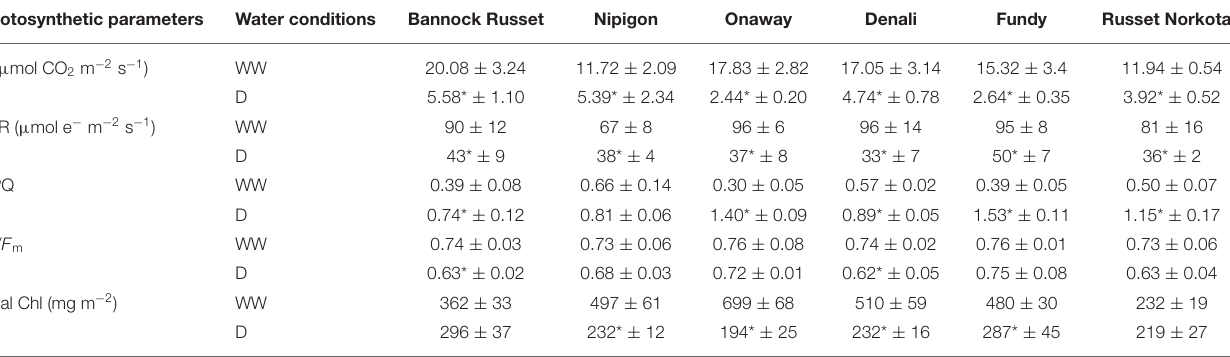
TABLE 2 | Effects of drought stress on photosynthetic and fluorescence characteristics of six potato genotypes grown under well-watered and drought conditions. Photosynthetic parameters